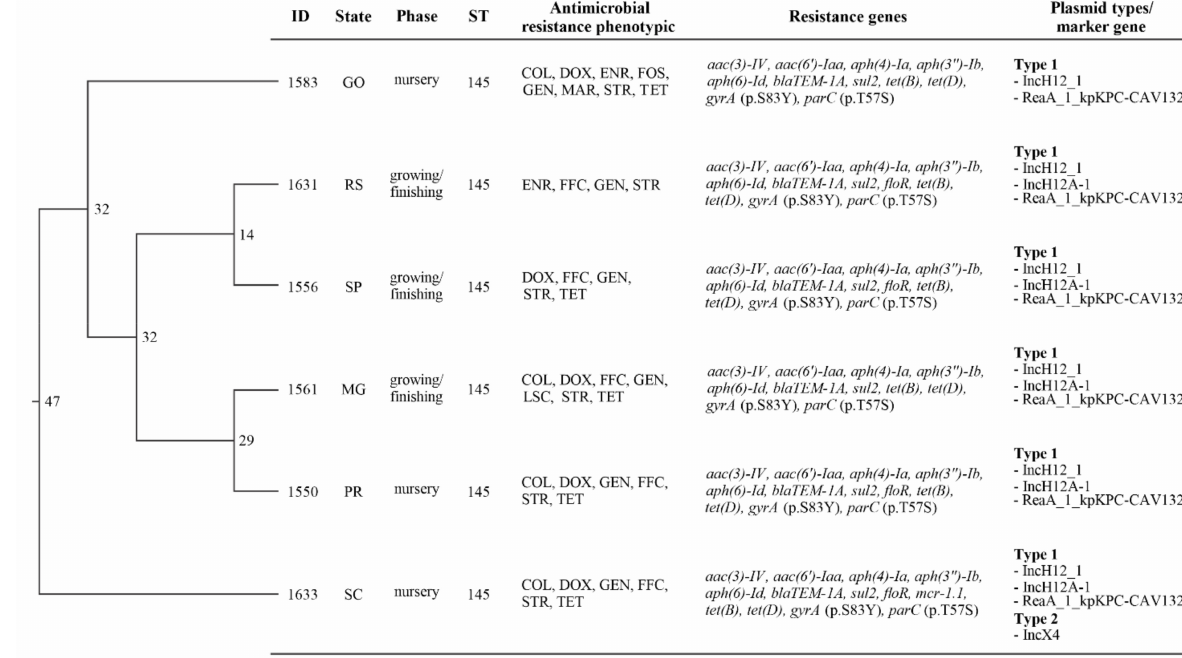
Figure 4. SNP tree together with results of the antimicrobial susceptibility tests, presence of antimicrobial resistance genes, and plasmids for the six sequenced isolates of Salmonella Choleraesuis from Brazil. SNP differences between branches are indicated with numbers in the dendrogram. COL, colistin; DOX, doxycycline; ENR, enrofloxacin; FOS, fosfomycin; FFC, florfenicol; GEN, gentamicin; LSC, lincomycin-spectinomycin; MAR, marbofloxacin; STR, streptomycin, TET, tetracycline; ST, sequence